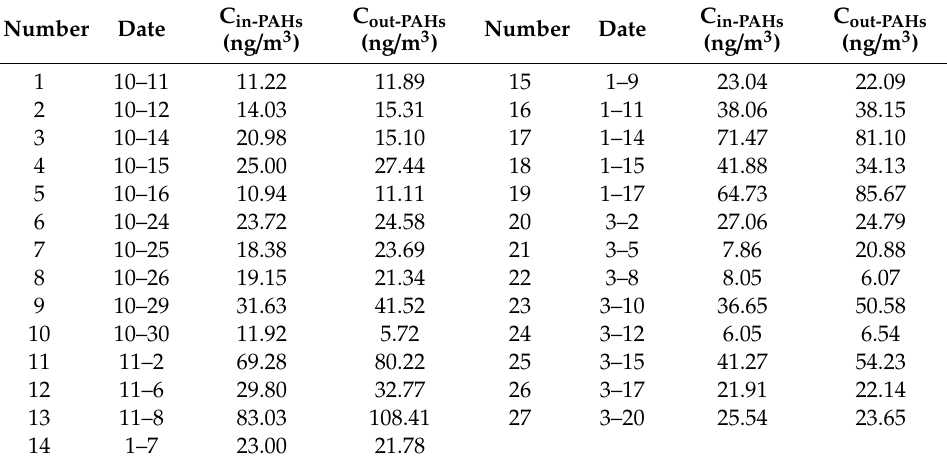
Table 4. Mass concentrations of total PAHs during sampling